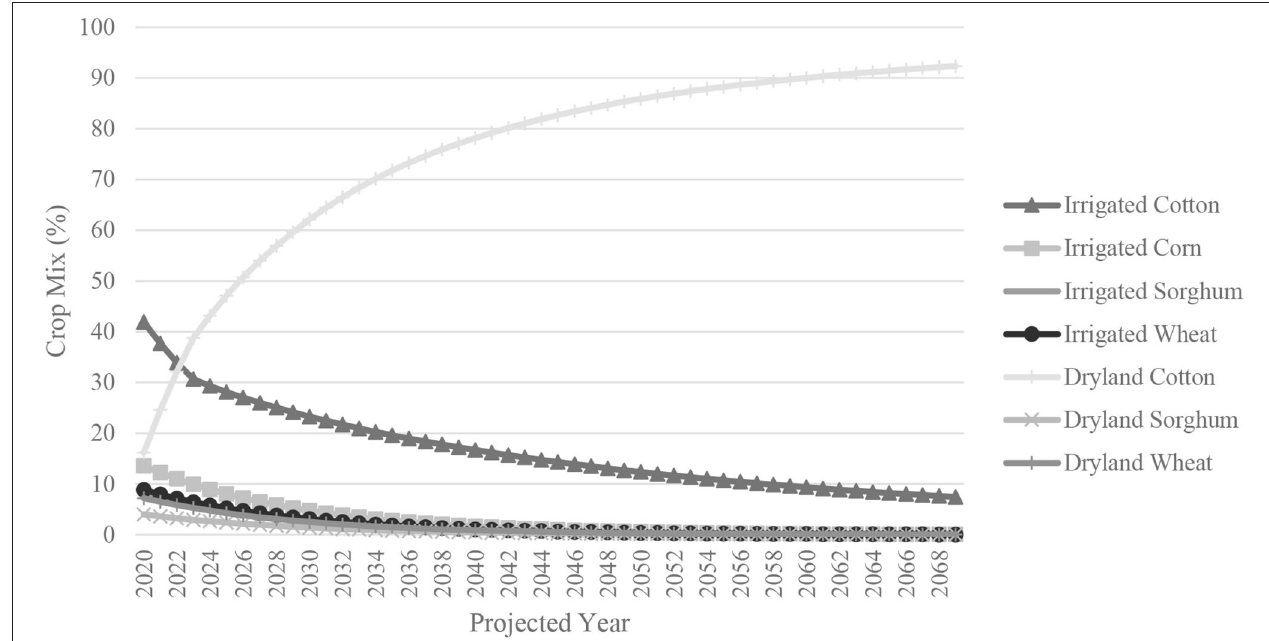
FIGURE 3 | Projection of future crop mix (%) in Hale County, Texas.